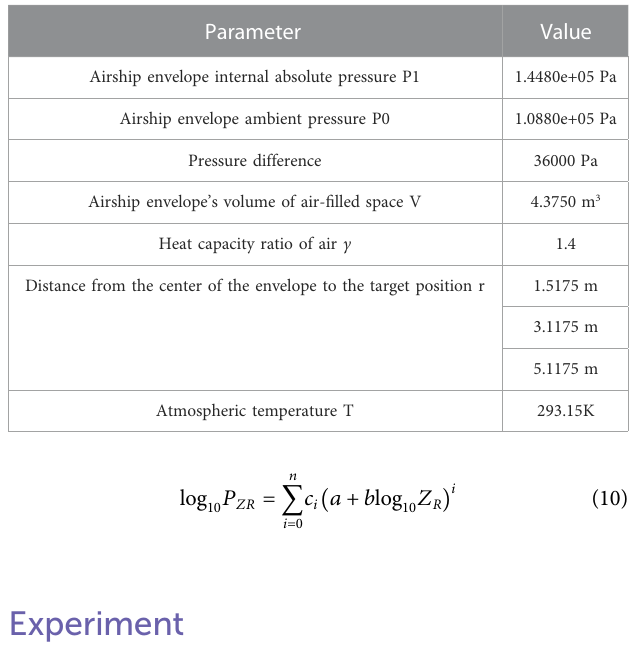
TABLE 2 Test parameters.